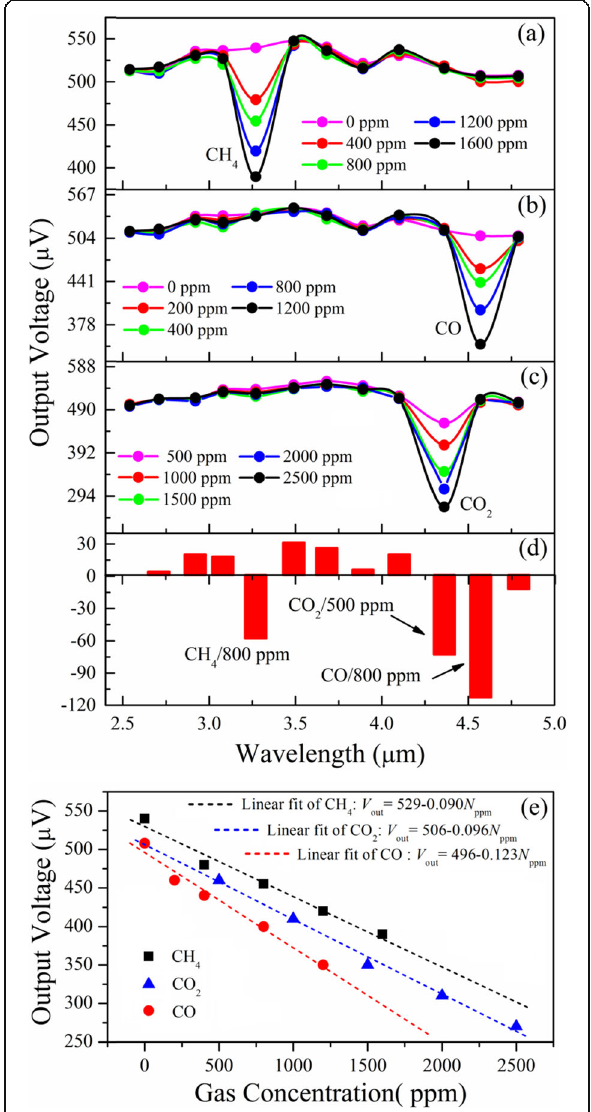
Fig. 10 Spectral response of CH 4 ( a ), CO ( b ), and CO 2 ( c ) at different concentrations; Spectral response histogram of mixed gases based on CH 4 /800 ppm, CO 2 /500 ppm, and CO/800 ppm ( d ); Linear dependence of output voltage on gas concentration ( e